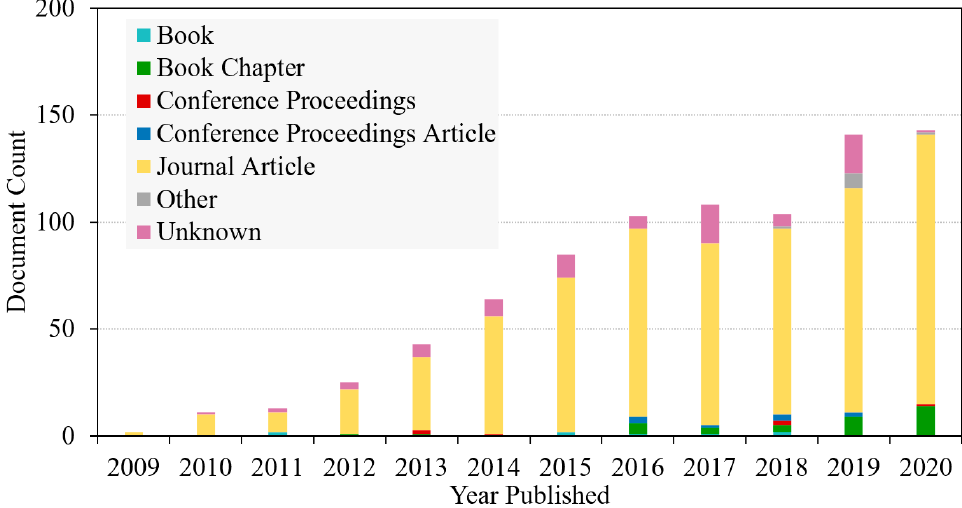
Figure 11. A chart of published manuscripts on the nanocellulose functionalization from Lens.org. Accessed on 15 February 2021.